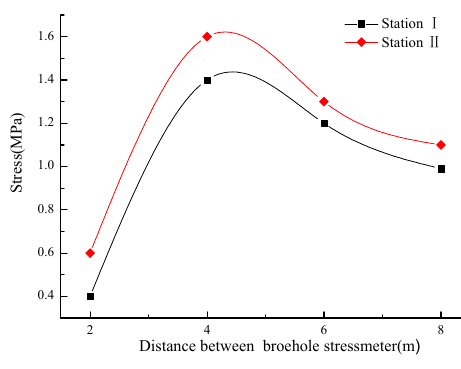
Figure 7. Pressure curves in coal mass.